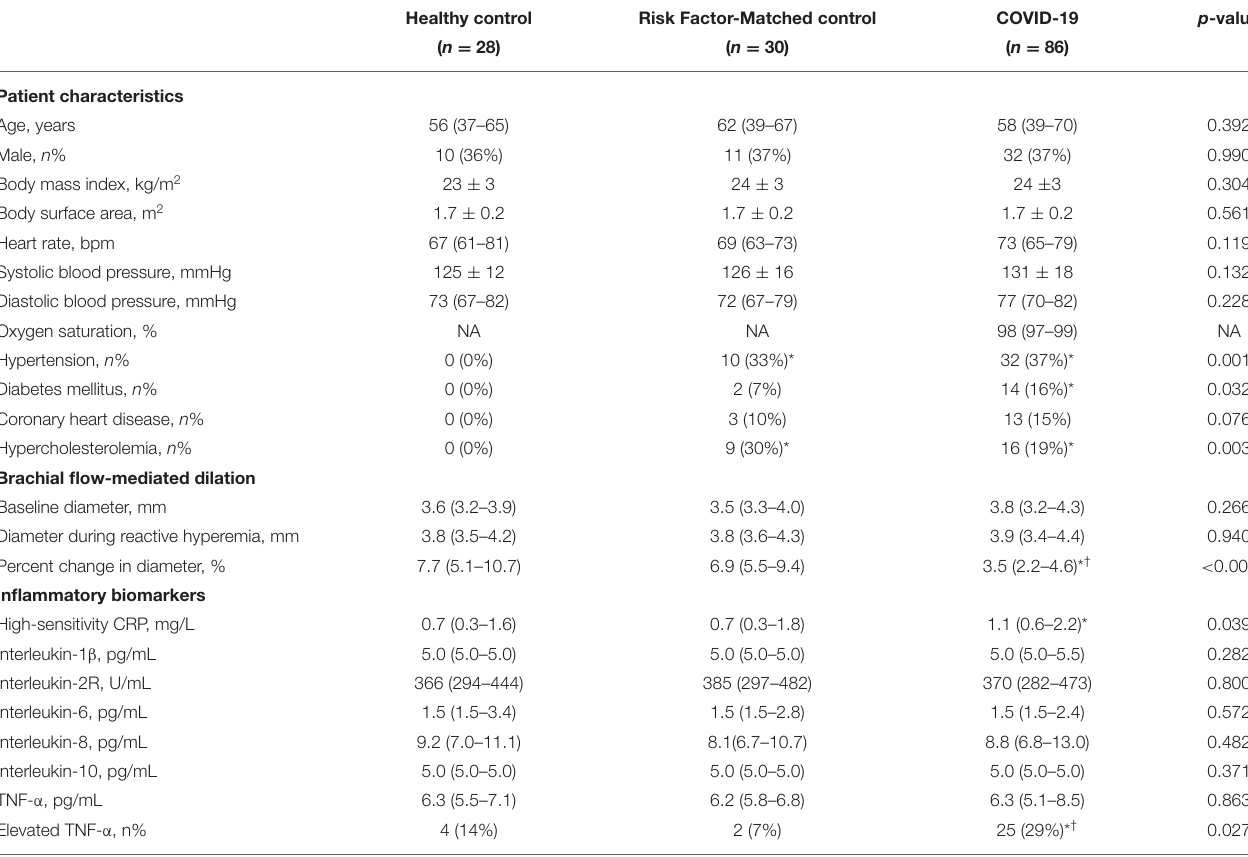
TABLE 1 | Clinical characteristics, brachial artery flow-mediated dilation, and inflammatory biomarkers of survivors of COVID-19 327 days after diagnosis.